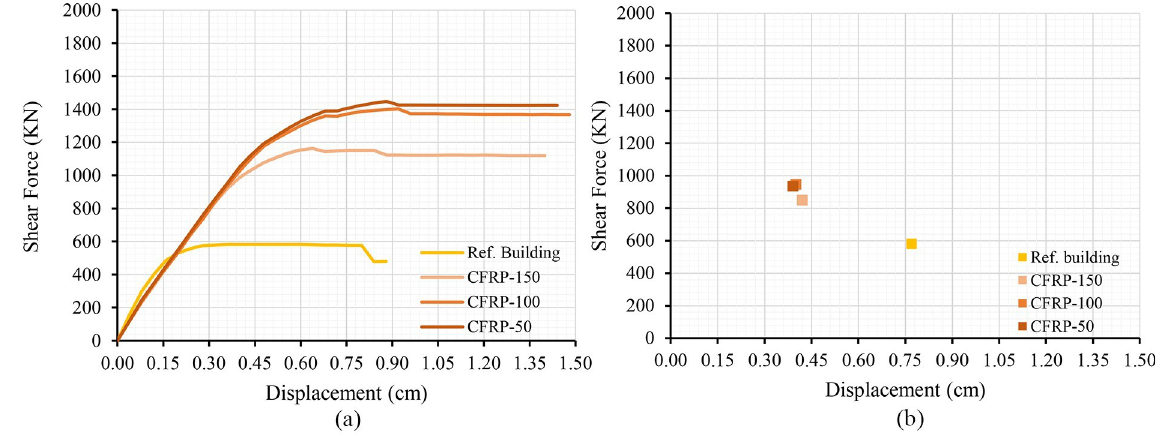
Fig 8. Capacity curves (a) and performance points (b) of the models adding CFRP bands varying the band spacing.